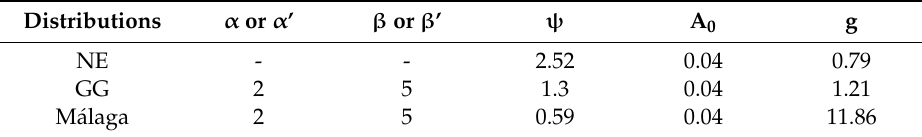
Table 1. Values of turbulence and pointing errors parameters.